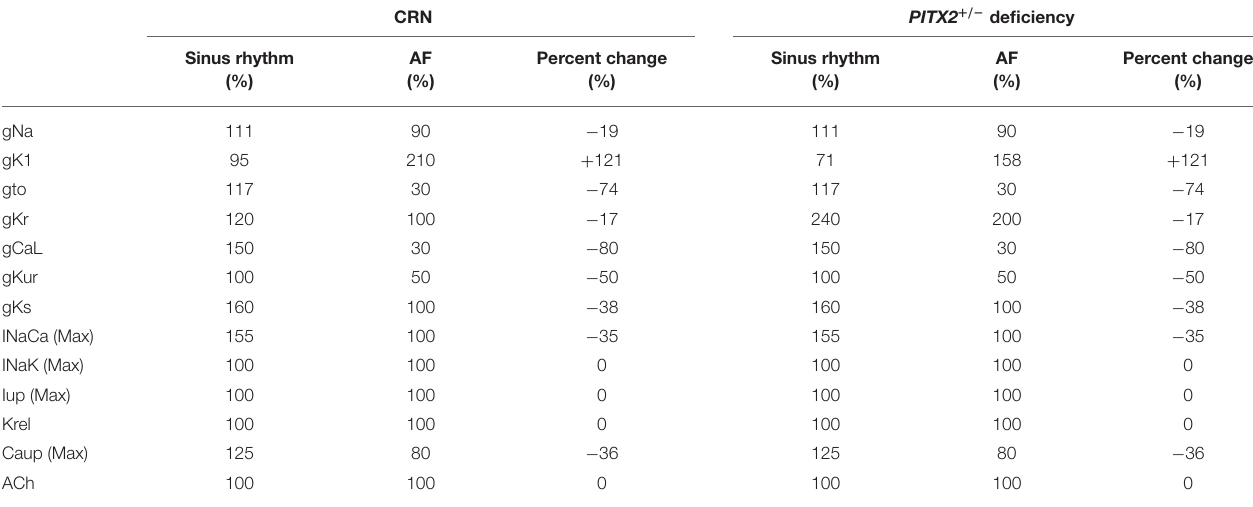
TABLE 1 | Ion currents change for genotypes.